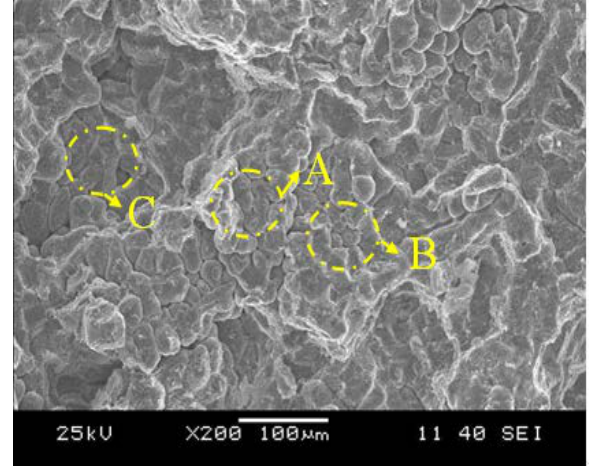
Figure 5. Macro fracture after casting cracking. ( a ) LD10 base material macro fracture, ( b ) foil added casting macro fracture.